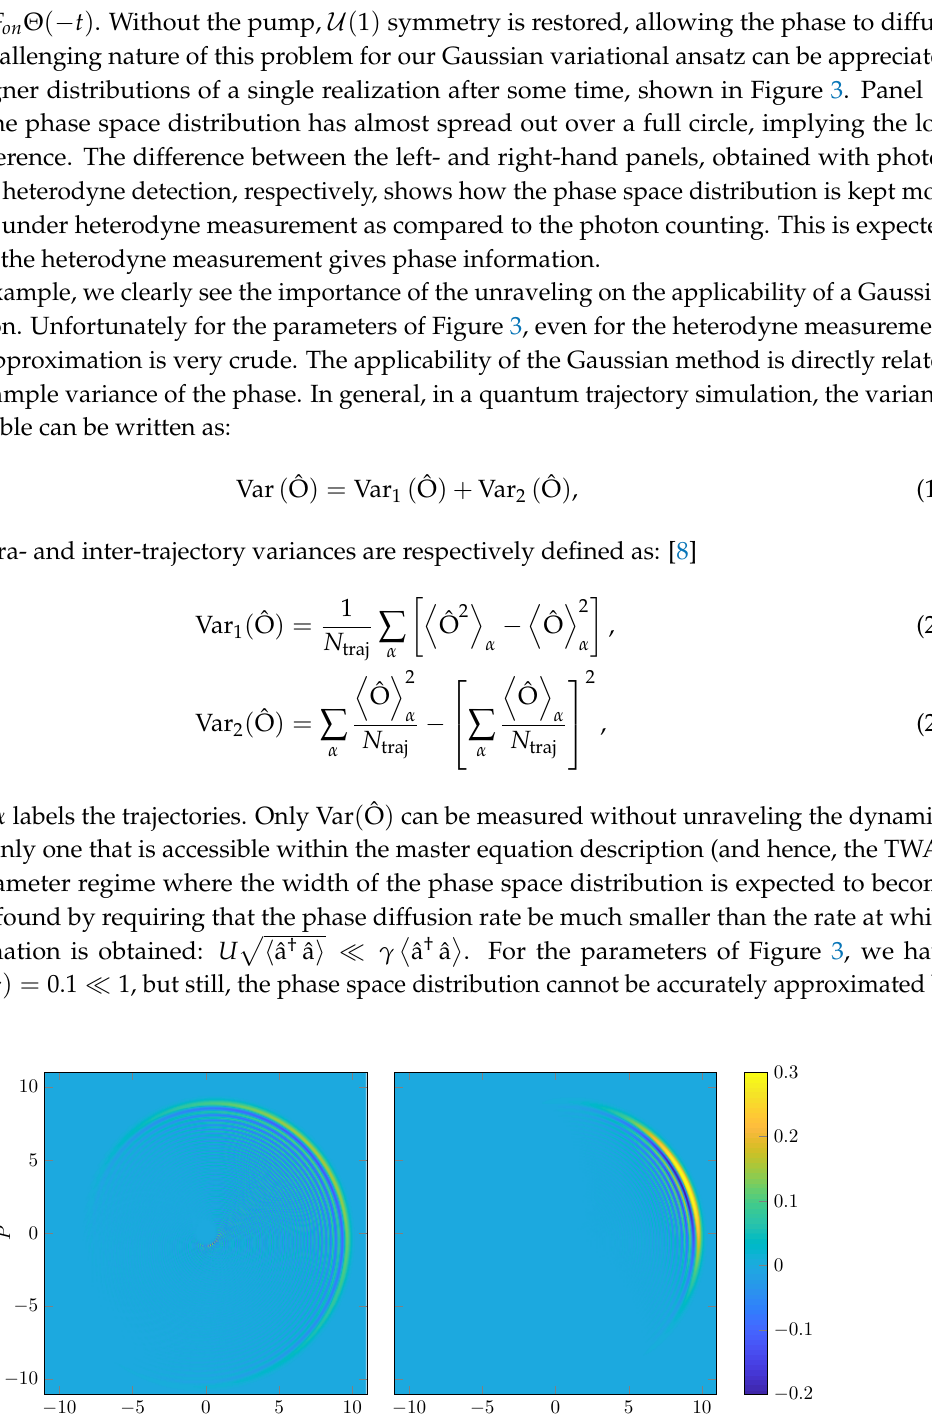
= α 10 | (cid:105) | (cid:105)